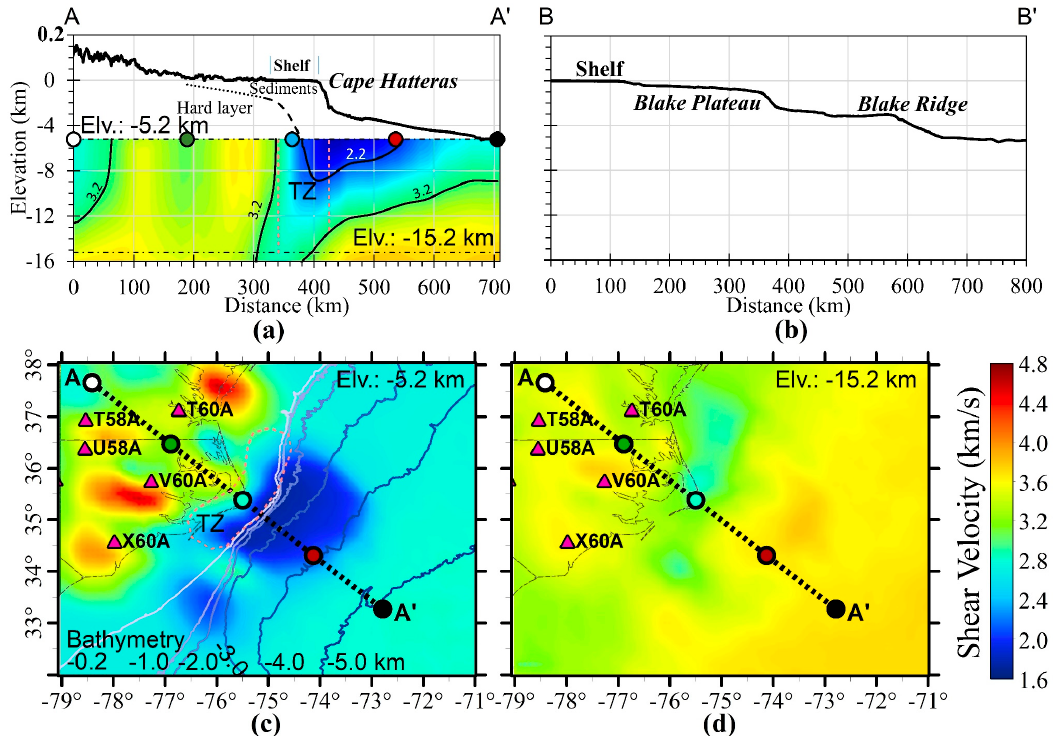
Figure 9. Topographic profiles of the continental margin along ( a ) A-A’ and ( b ) B-B’ (marked in Figure 1) based on General Bathymetric Chart of the Oceans (GEBCO, 2014). The shear velocity profile and contours in ( a ) are reproduced on [15]. The geophysical interface between sediments and bedrock is estimated (black dotted line) by horizontal-to-vertical spectral ratio (HVSR) method and was extended seaward by inference (black dashed line) to connect with the 2.2 km/s shear velocity contour. A transitional zone (TZ) with the largest shear velocity gradient is identified and outlined by the two pink dashed lines in ( a ). The shear velocity models inside the white box outlined in Figure 1 are generated for elevations (Elv.) of − 5.2 km ( c ) and − 15.2 km ( d ) based on [15].